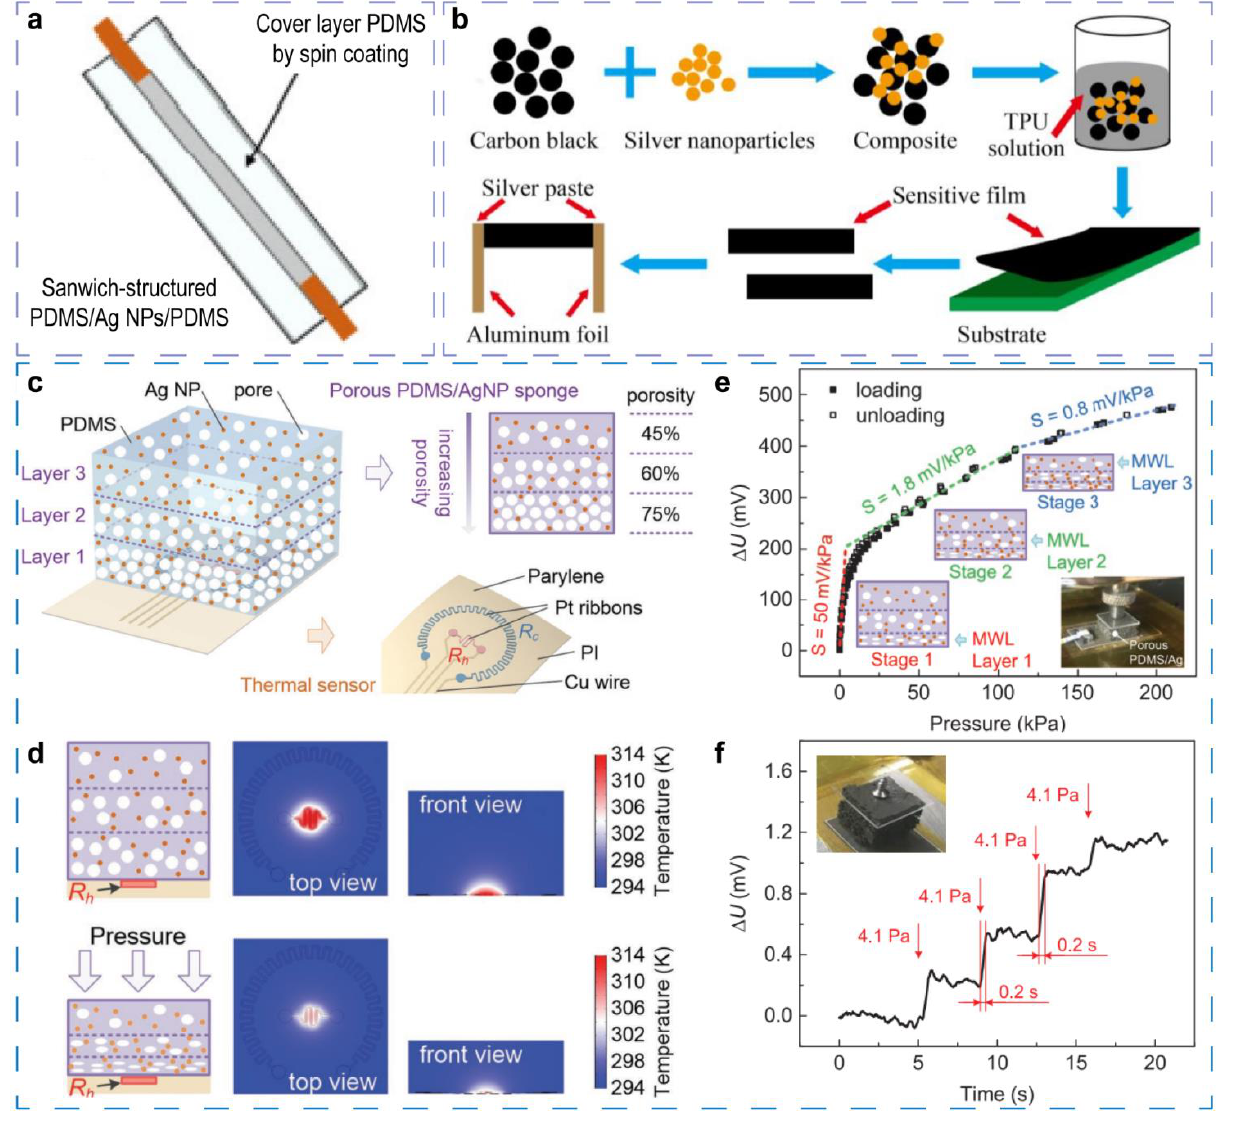
Figure 1. Multifunctional mechanical sensors employing 0-D materials as sensing components. ( a ) A sample and typical sandwich structure example for mechanical sensors. Reproduced with permission. [37] Copyright 2020, Springer Nature.